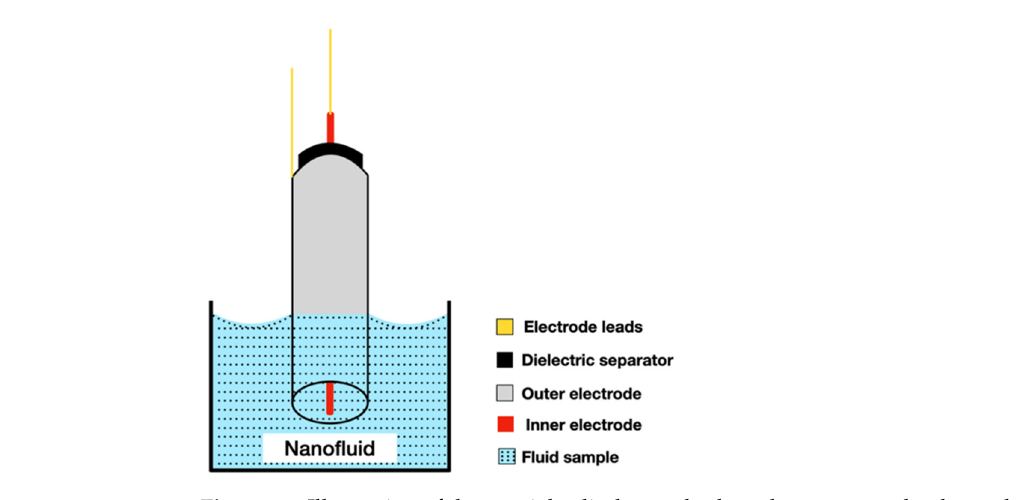
Figure 10. Illustration of the coaxial cylinder method used to measure the thermal conductivity of a liquid (adapted from Schiefelbein et al. (1998) [25]).